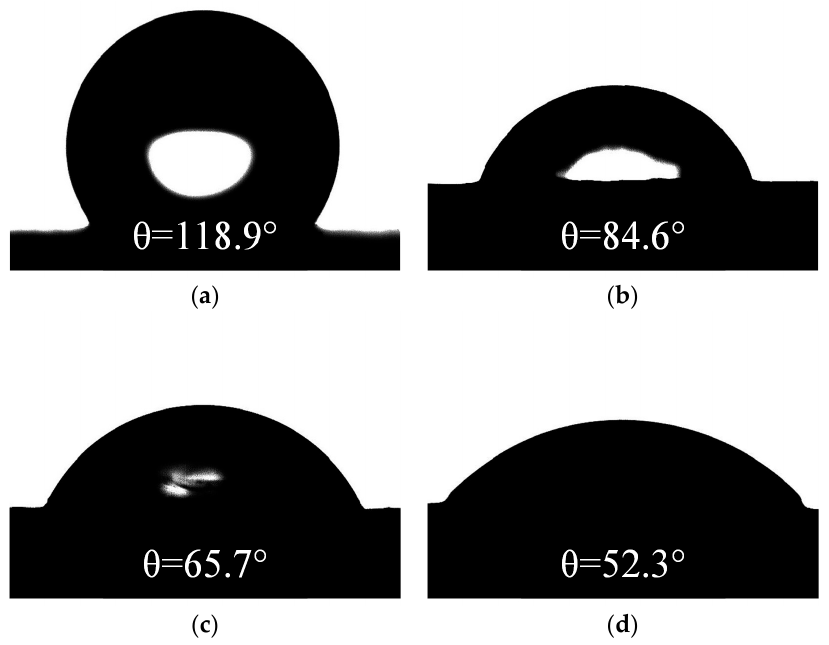
Figure 9. Static contact angles at different applied voltages ( γ 20 = 1000 μ S/cm, t = 8 h). ( a ) DC 0 kV, ( b ) DC 1.6 kV, ( c ) DC 3.2 kV, ( d ) DC 3.6 kV.